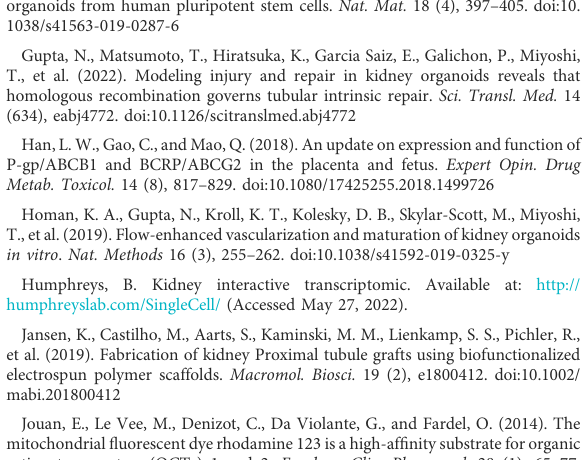
SUPPLEMENTARY FIGURE S1 Fixation staining of organoid attached on chamber slides showed nephron tissue segmentations. SUPPLEMENTARY TABLE S1 Antibodies used for